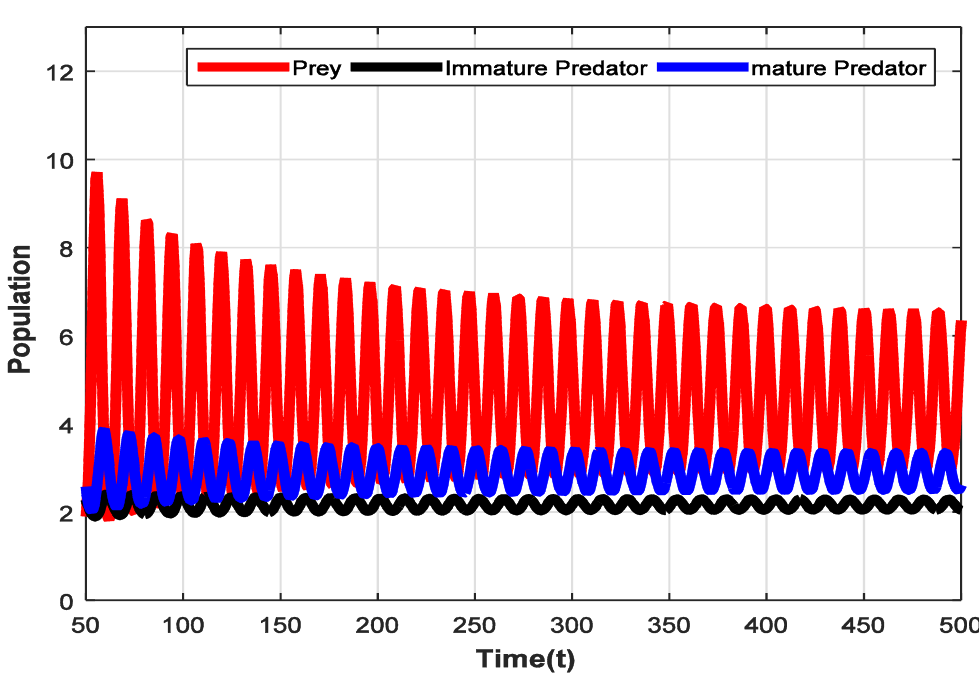
Figure 11. Population graph for 𝛾 =